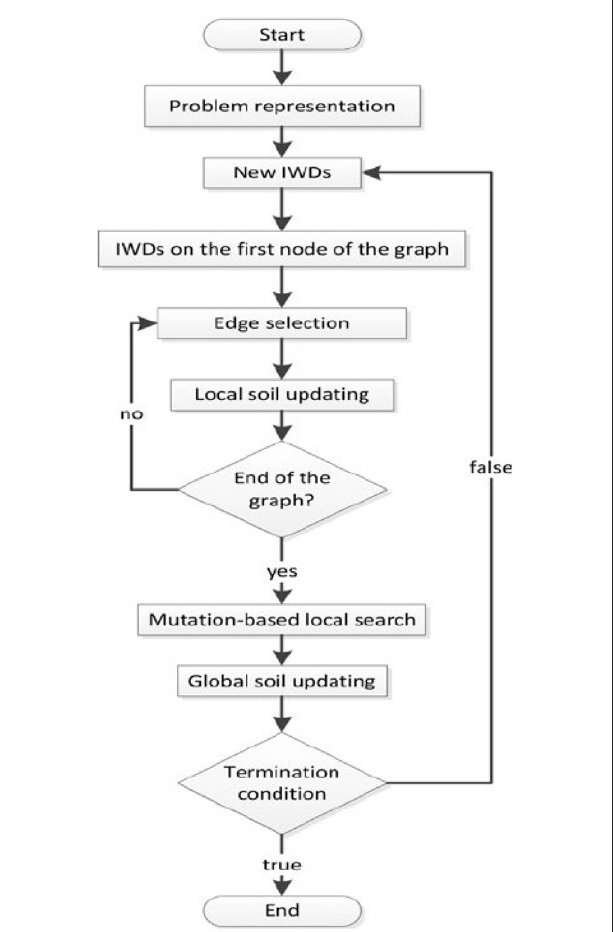
FIGURE 3 | The graph shows the programming of the Water Drop (WD) optimization (